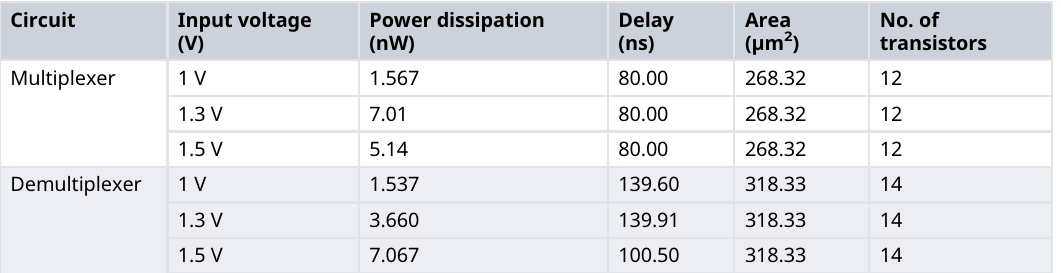
Table 1. Results of the simulation for the multiplexer (MUX) and demultiplexer (DEMUX).